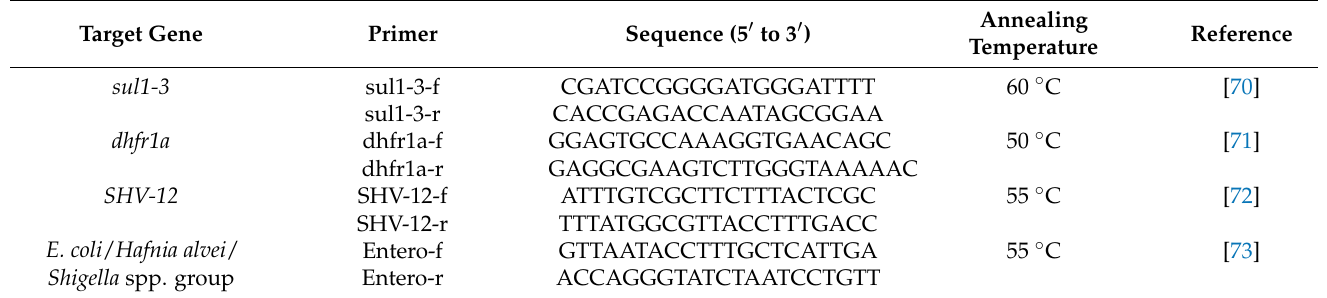
Table 7. Target gene, sequences, and annealing temperatures of primers used for the detection of resistance genes and bacterial group Escherichia coli / Hafnia / Shigella in excreta